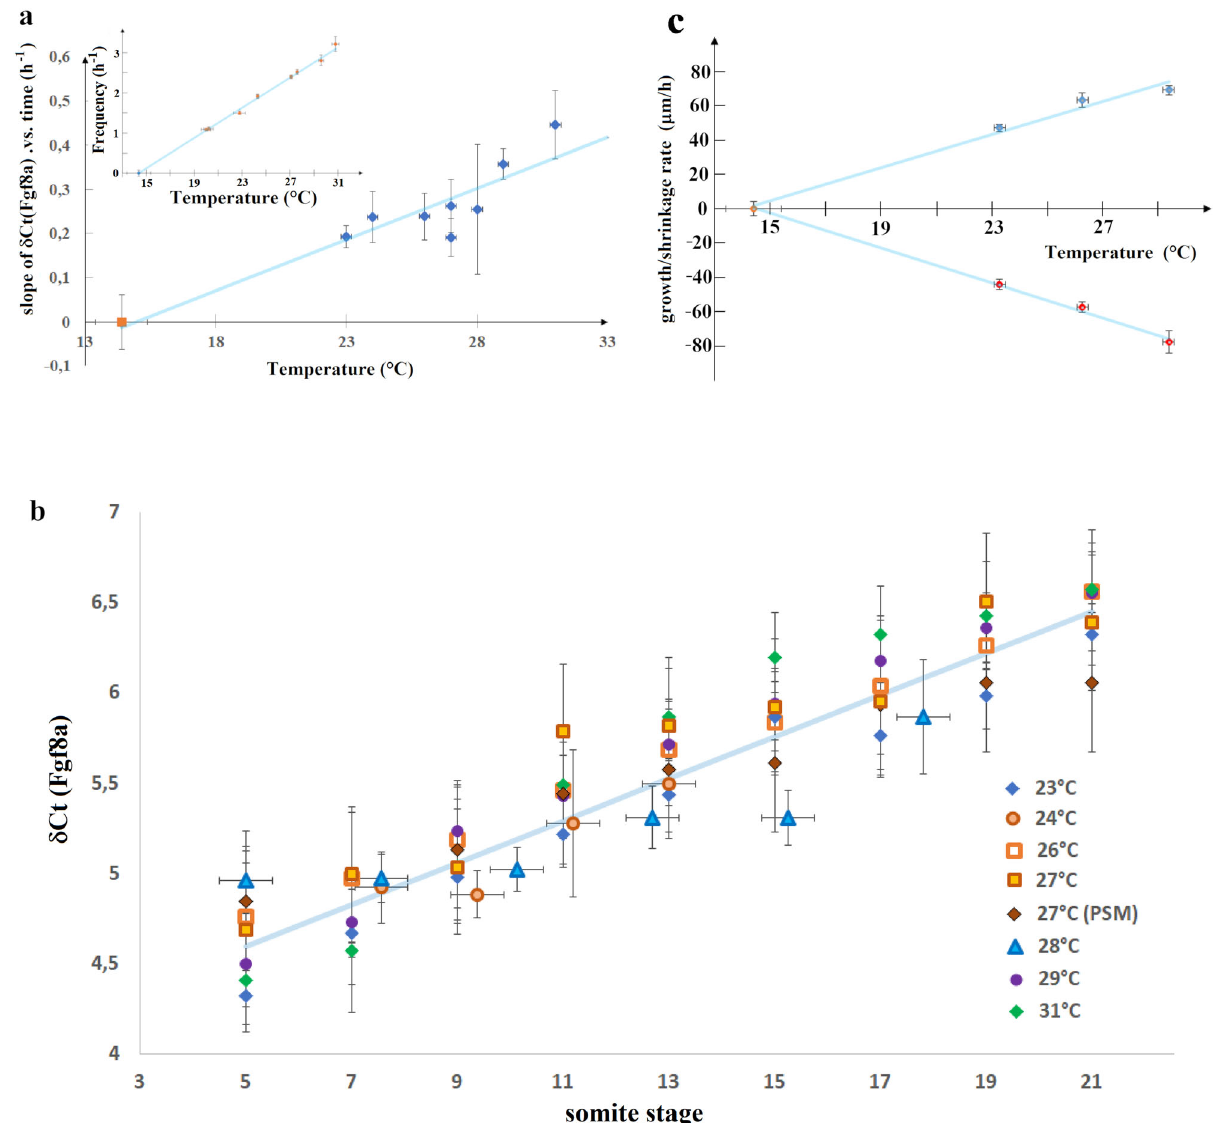
Fig. 6 Variation with temperature of the dynamics of fgf8 mRNA, tail growth and PSM shrinkage. a Variation with temperature of the slope α of δ Ct ( fgf 8( t )) vs time (Fig. 5), which is linearly related to the exponential decay rate of <[ fgf8m ]>: 1/ τ = ln(2) α . The red point at 27 °C is from PSM only data. The data can be fi t (blue line) by α = a ( T − T c) with: a = 0.022 ± 0.0038; T c = 14.4 °C ( Χ 2 = 6.57; DF = 6). Inset : variation of the clock frequency f s = 1/ τ s vs temperature 2 (data from Schröter et al. 2 ) which can be fi t by f s = a s ( T − Tc ) with a s = 0.188. b Another w a y to represent the data shown in a : since δ Ct ( fgf 8 ( t )) varies with temperature in a similar way as the segmentation period, τ s , the δ Ct ( fgf 8( t )) data taken at different temperatures collapse on the same curve as a function of somite stage: s = t/ τ s ( = number of segmentation periods). The data at all temperatures can be fi t (blue line) by δ Ct = a ′ s + b , with a ′ = 0.122 ± 0.0098 and b = 3.955 ( χ 2 = 26.5; DF = 55). Notice that as expected: a = a ′ ∙ a s . c variation with temperature of the growth rate (blue points) and the PSM shrinkage rate (red points) and linear best fi ts (blue lines): y = β ( T − Tc) with β = 4.79 ± 0.46 ( χ 2 = 6.35; DF = 2; blue points) and β = − 5.08 ± 0.20 ( χ 2 = 0.51; DF = 2; red